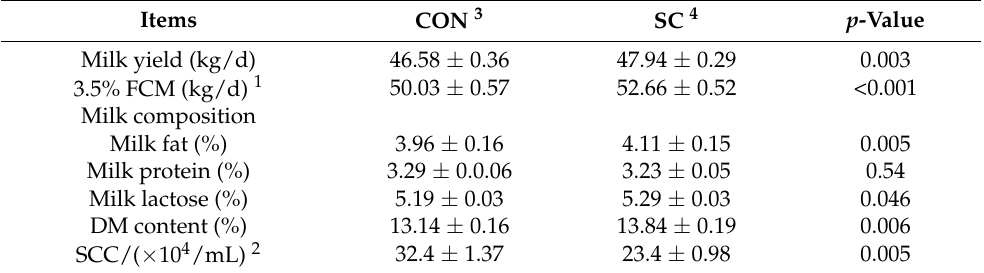
Table 2. Effects of SC on dry matter intake milk yield and milk composition of lactating dairy cows.